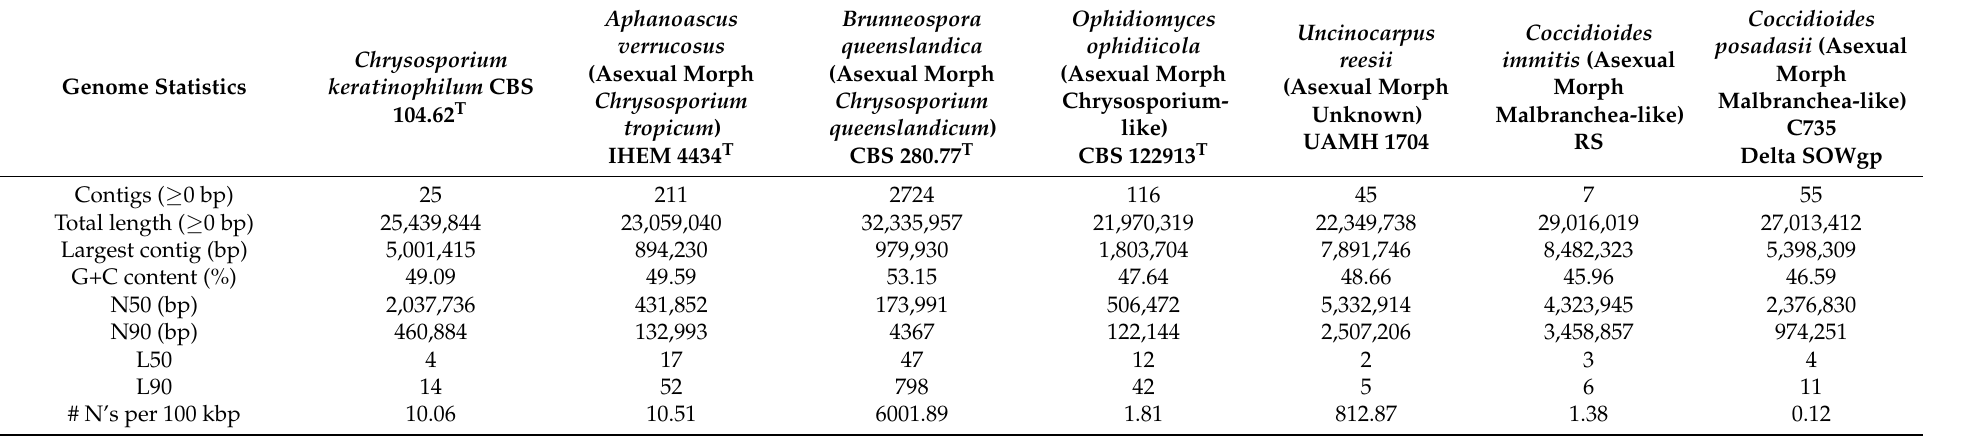
Table 2. Genome assembly statistics of Chrysosporium keratinophilum and phylogenetically related onygenalean